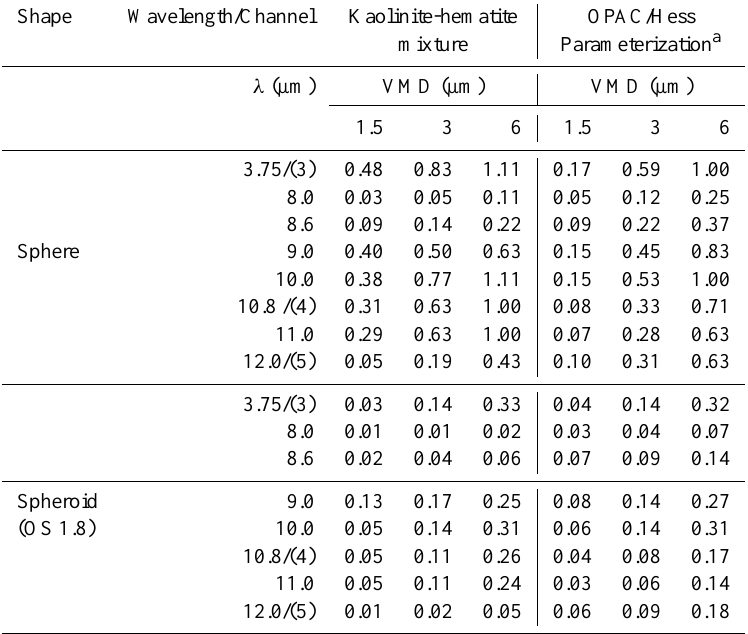
Table 4. MEE ratios ( α IR /α NIR ) – from the near to thermal IR. Shape Wavelength/Channel Kaolinite-hematite